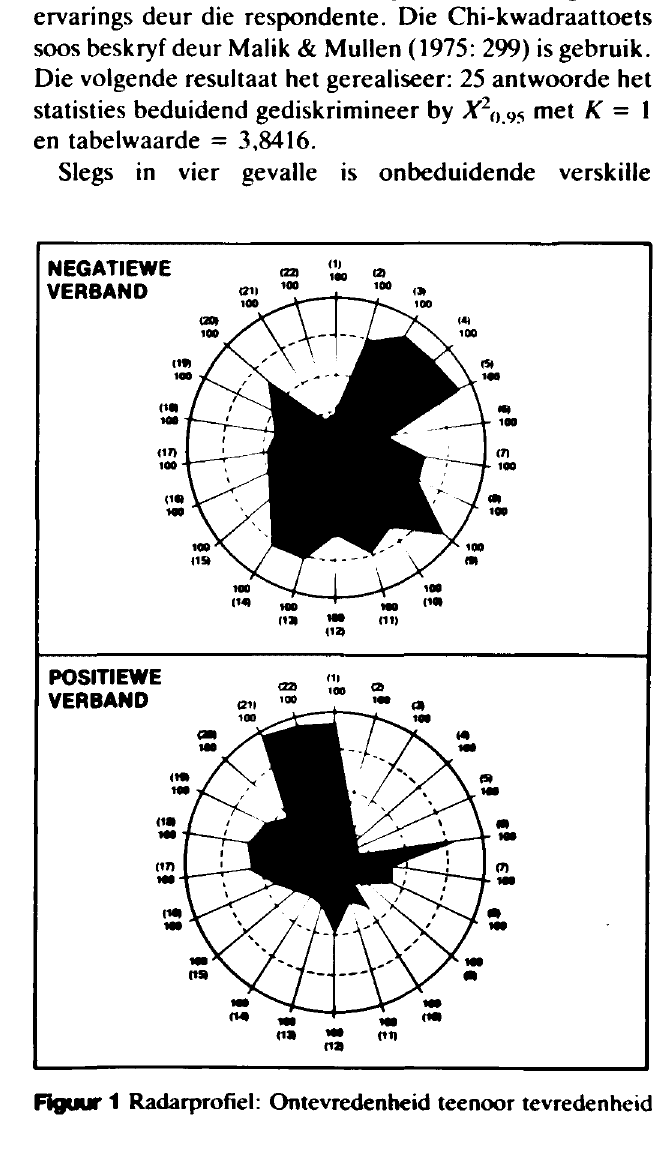
Flguw 1 Radarprofiel: Ontevredenheid teenoor